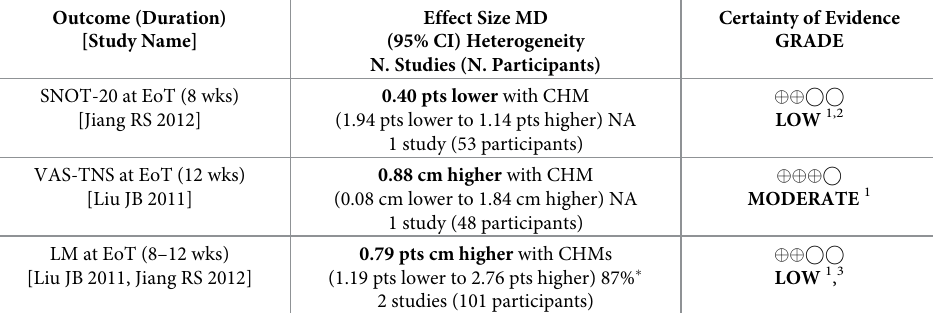
Table 4. GRADE for oral Chinese herbal medicine versus pharmacotherapy for chronic rhinosinusitis: Double- dummy